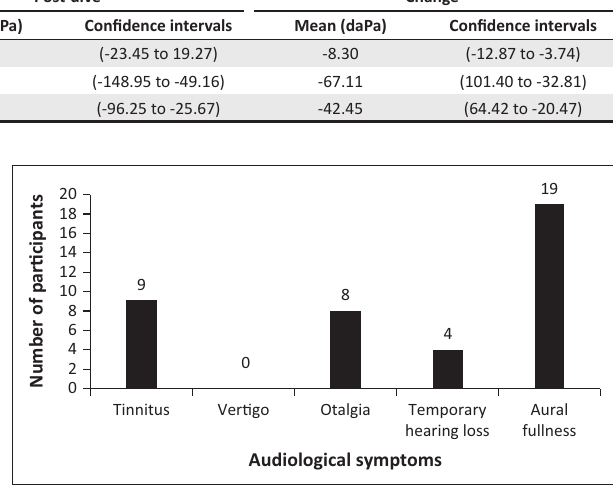
FIGURE 1: Audiological symptoms experienced by participants.